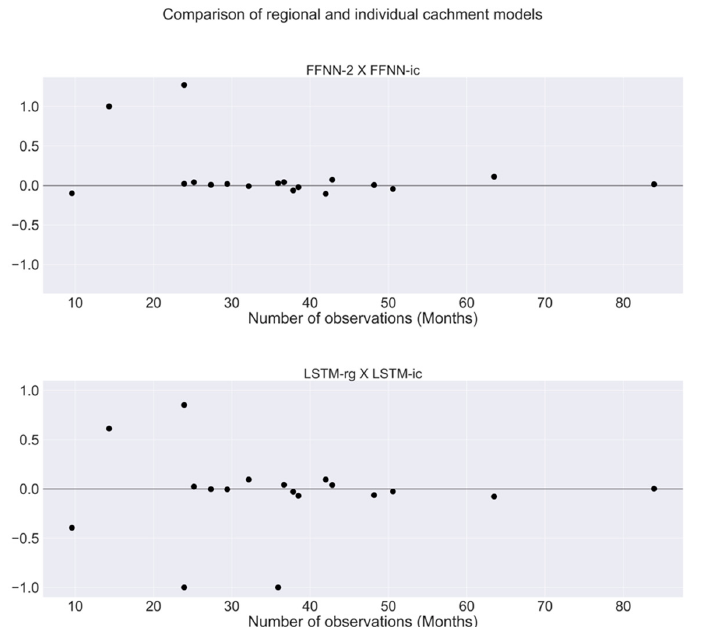
Figure 11. The y-axis represents the logarithm of ratio of the NSE index of the FFNN-2 and LSTM-ic over the NSE index from the FFNN-ic and LSTM-ic models, respectively, against the number of data observations in the basin (x-axis).